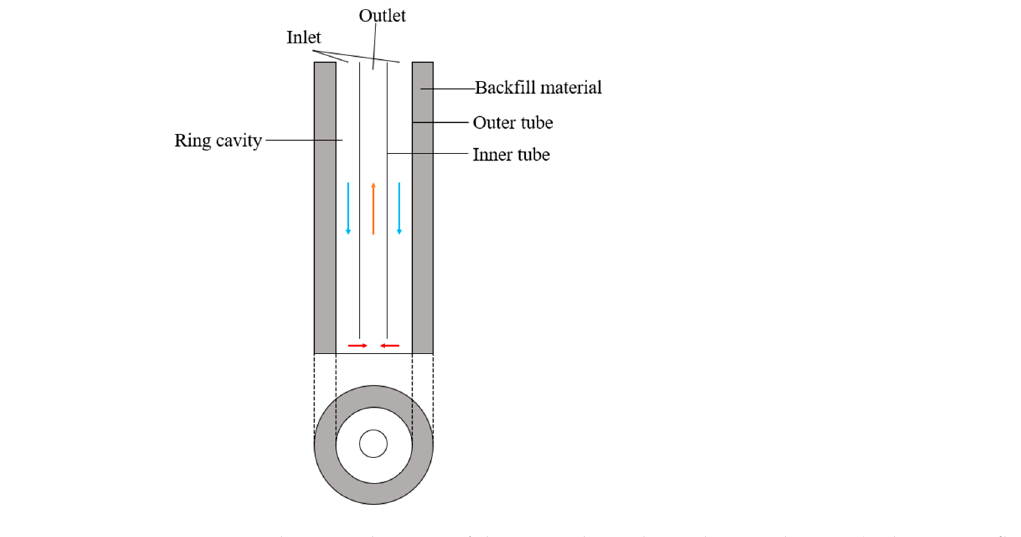
Figure 3. Schematic diagram of the casing buried pipe heat exchanger (red arrows—fluid with high temperature; blue arrows—fluid with low temperature). Table 1. Basic parameters of buried pipe.